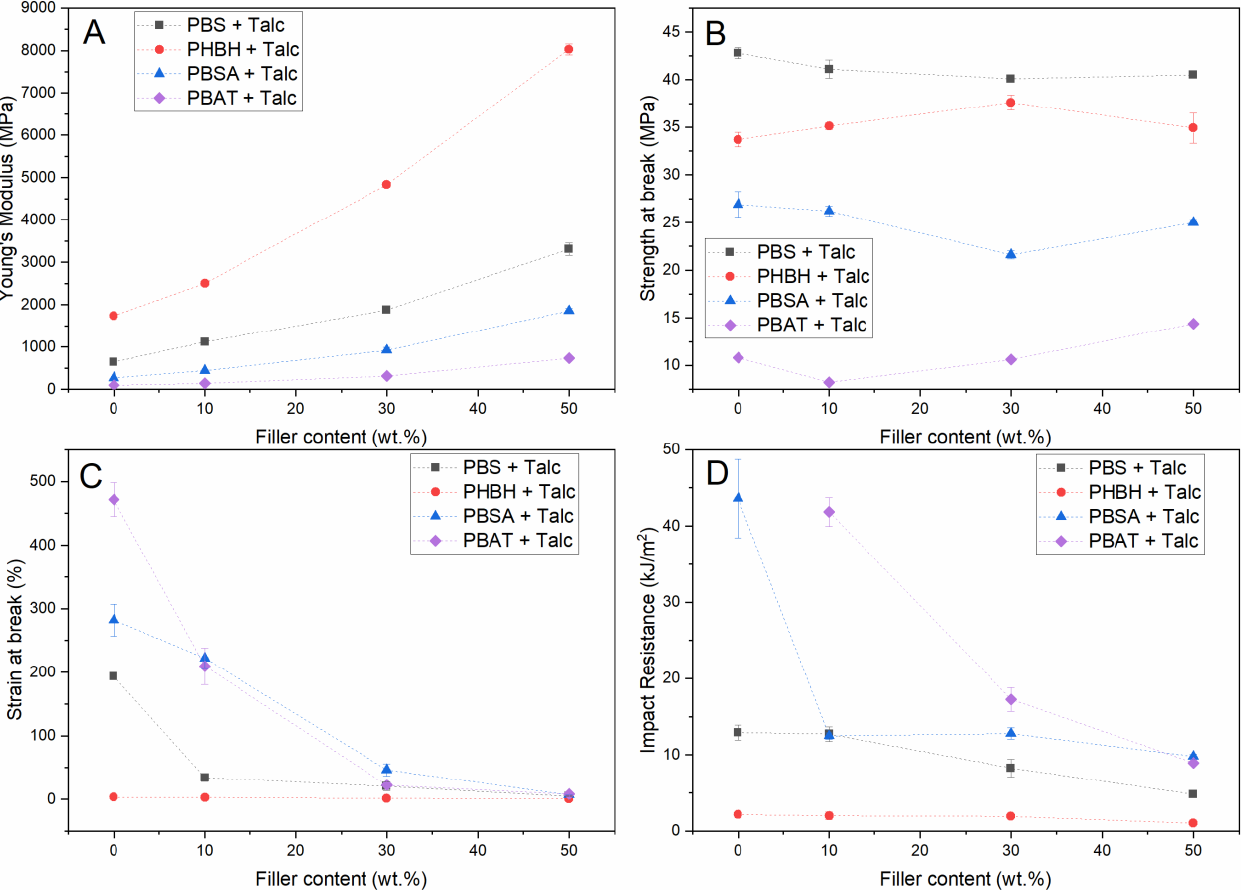
Figure 5. Mechanical properties (Young’s modulus ( A ), strength at break ( B ), strain at break ( C ), and notched impact resistance ( D )) of talc-filled PBS, PHBH, PBSA, and PBAT.